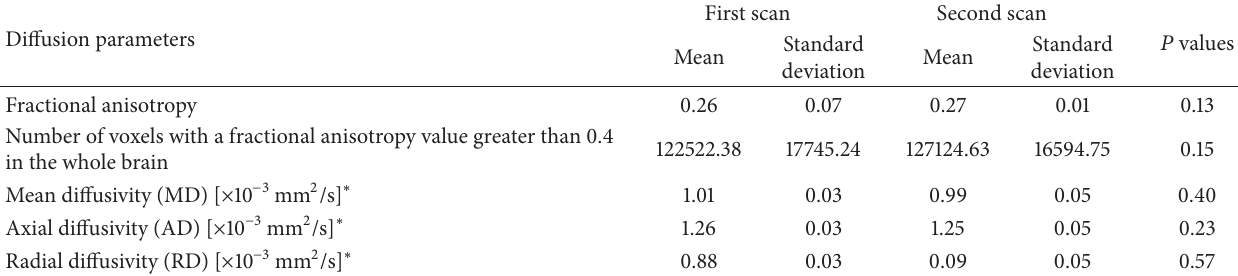
Table 5: Comparison of diffusion tensor parameters in normal healthy participants.